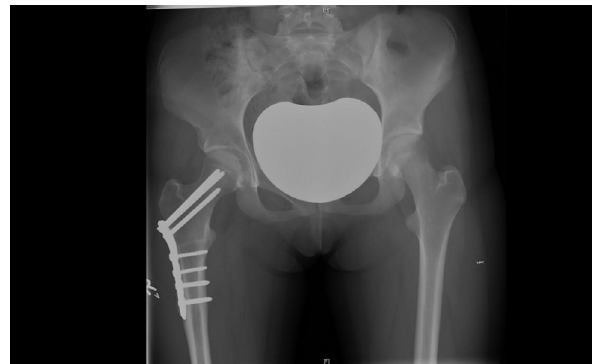
Figure 1. Radiograph of pelvis and hips, at three months postderotation proximal femoral osteotomy on right side.